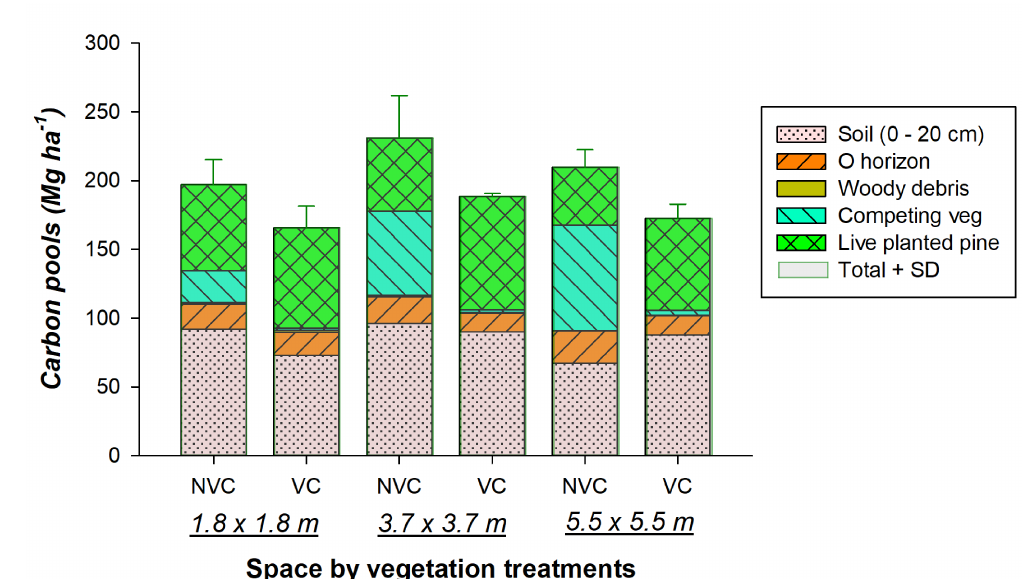
Figure 3. Age 28 total ecosystem carbon pools in ponderosa pine plantations under combinations of understory vegetation control (VC) and non-control (NVC) and three different levels of planting spacings at Challenge Experimental Forest, California, USA.